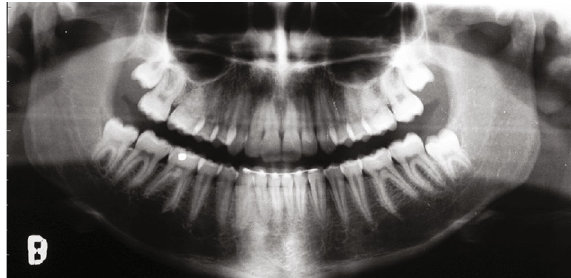
Figure 11: 2-year follow-up panoramic radiograph.